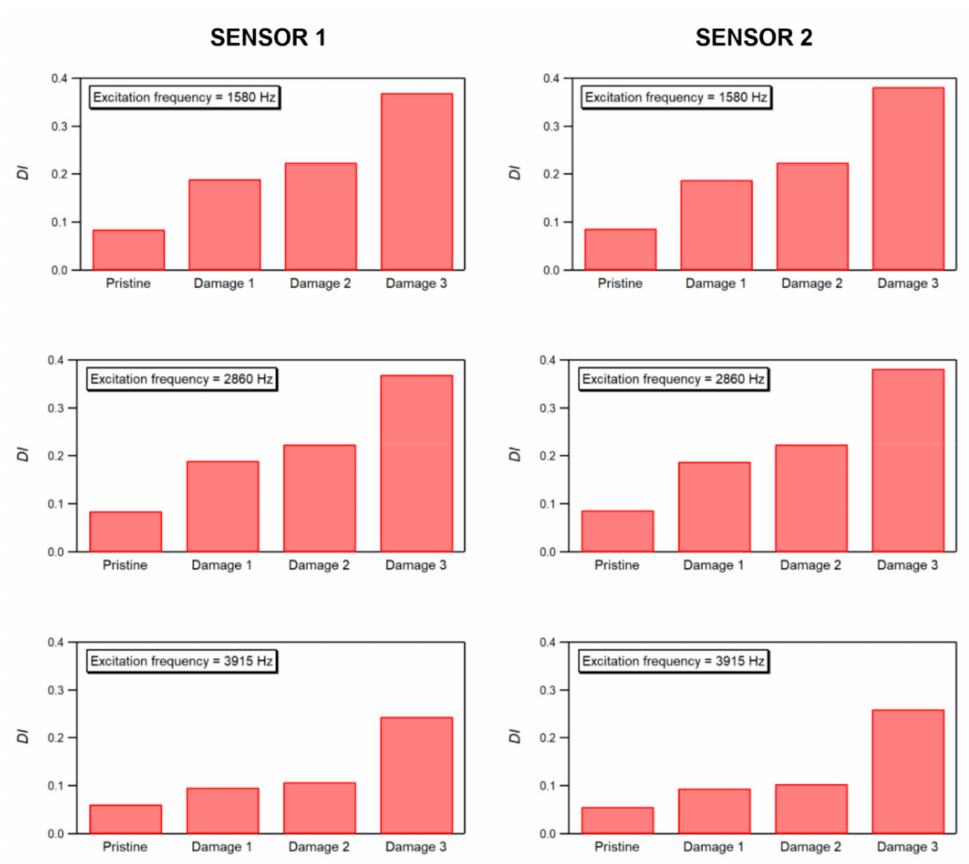
Figure 6. Harmonic excitation: values of the damage index DI calculated for the different excitation frequencies at increasing damage